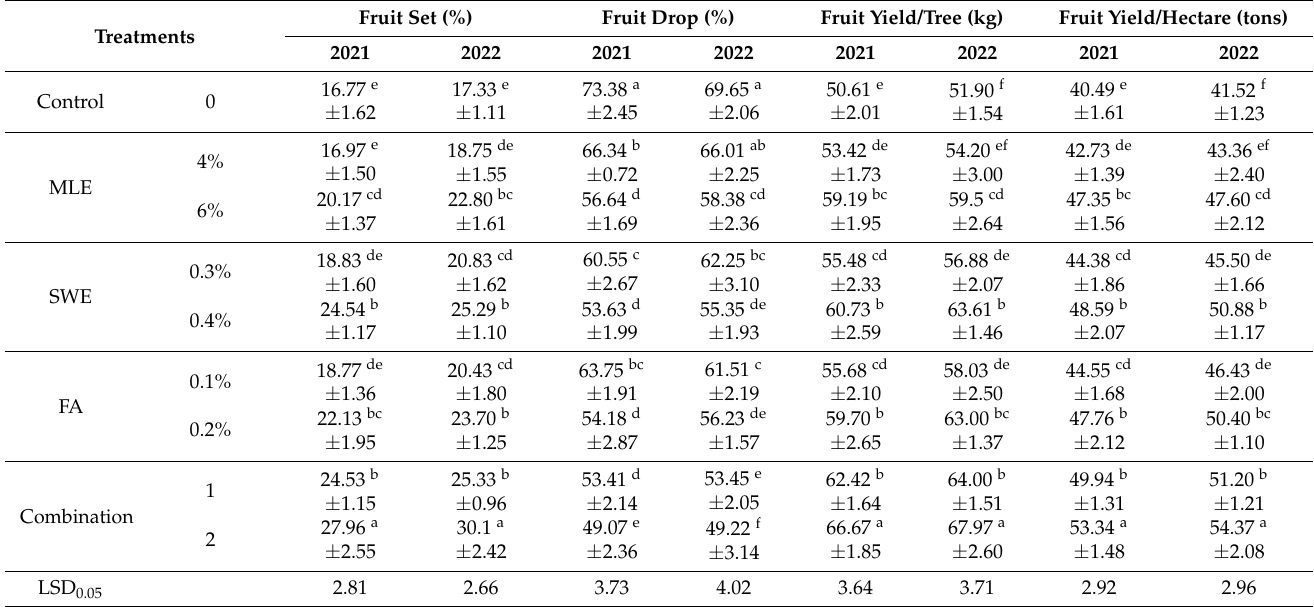
Table 3. The influence of the spraying of MLE, SWE and FA and their combinations on fruit set and drop % and yields per tree and per hectare of apple cv. Anna during 2021 and